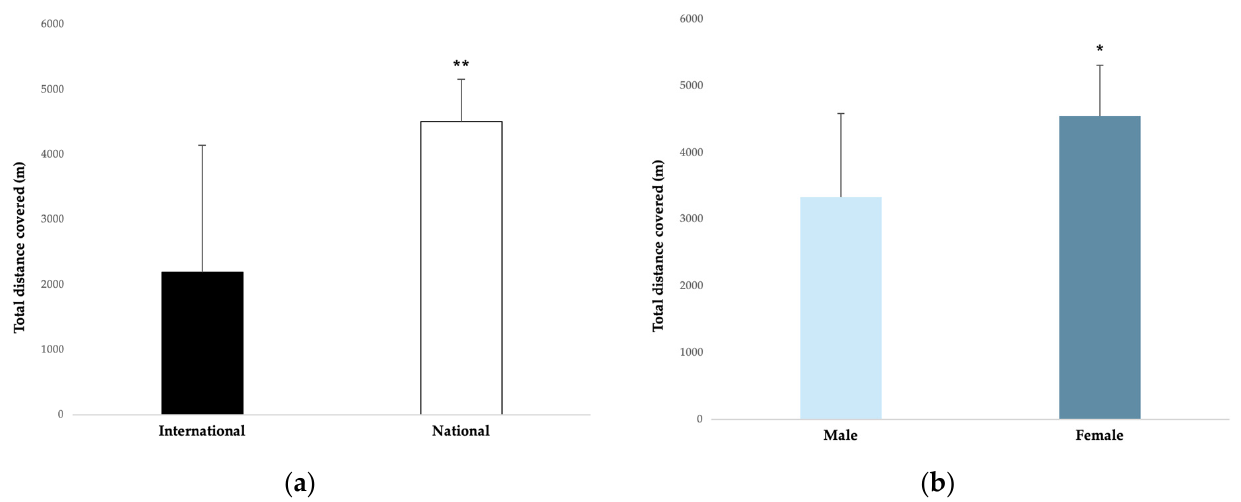
Figure 2. ( a , b ). Total distance covered according to the competition level and gender. The magnitude of the standardised differences (effect size) between the competition level and gender is indicated by the number of symbols: one symbol stands for a moderate difference and two for a large difference. TDC differed according to playing positions. Backs (ES = 0.7) and wings (ES = 0.6) covered a moderately greater total distance than pivots (Figure